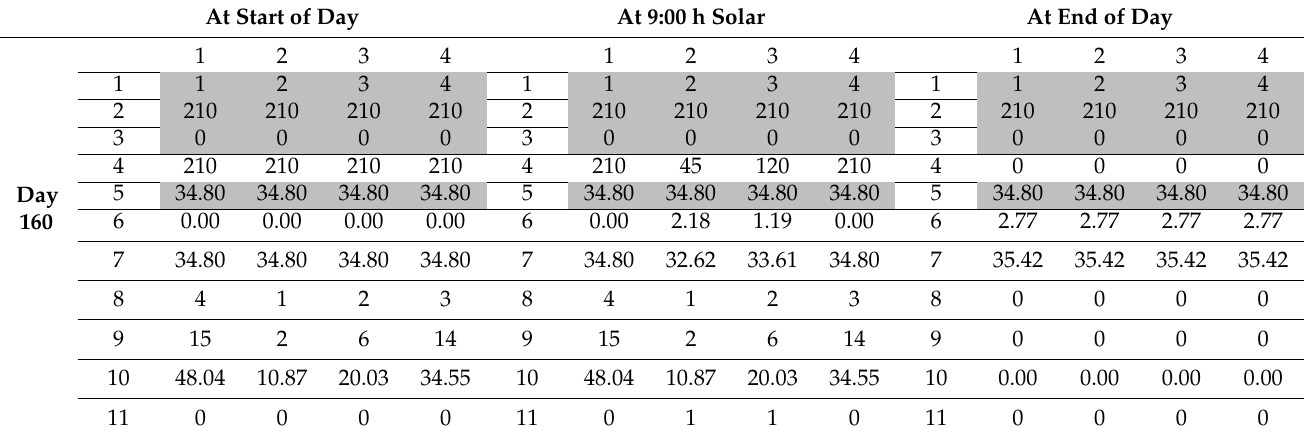
Table 10. Evolution of the daily work matrix for the 160th day of the year (in the irrigation season). The shaded rows have fixed values for the entire